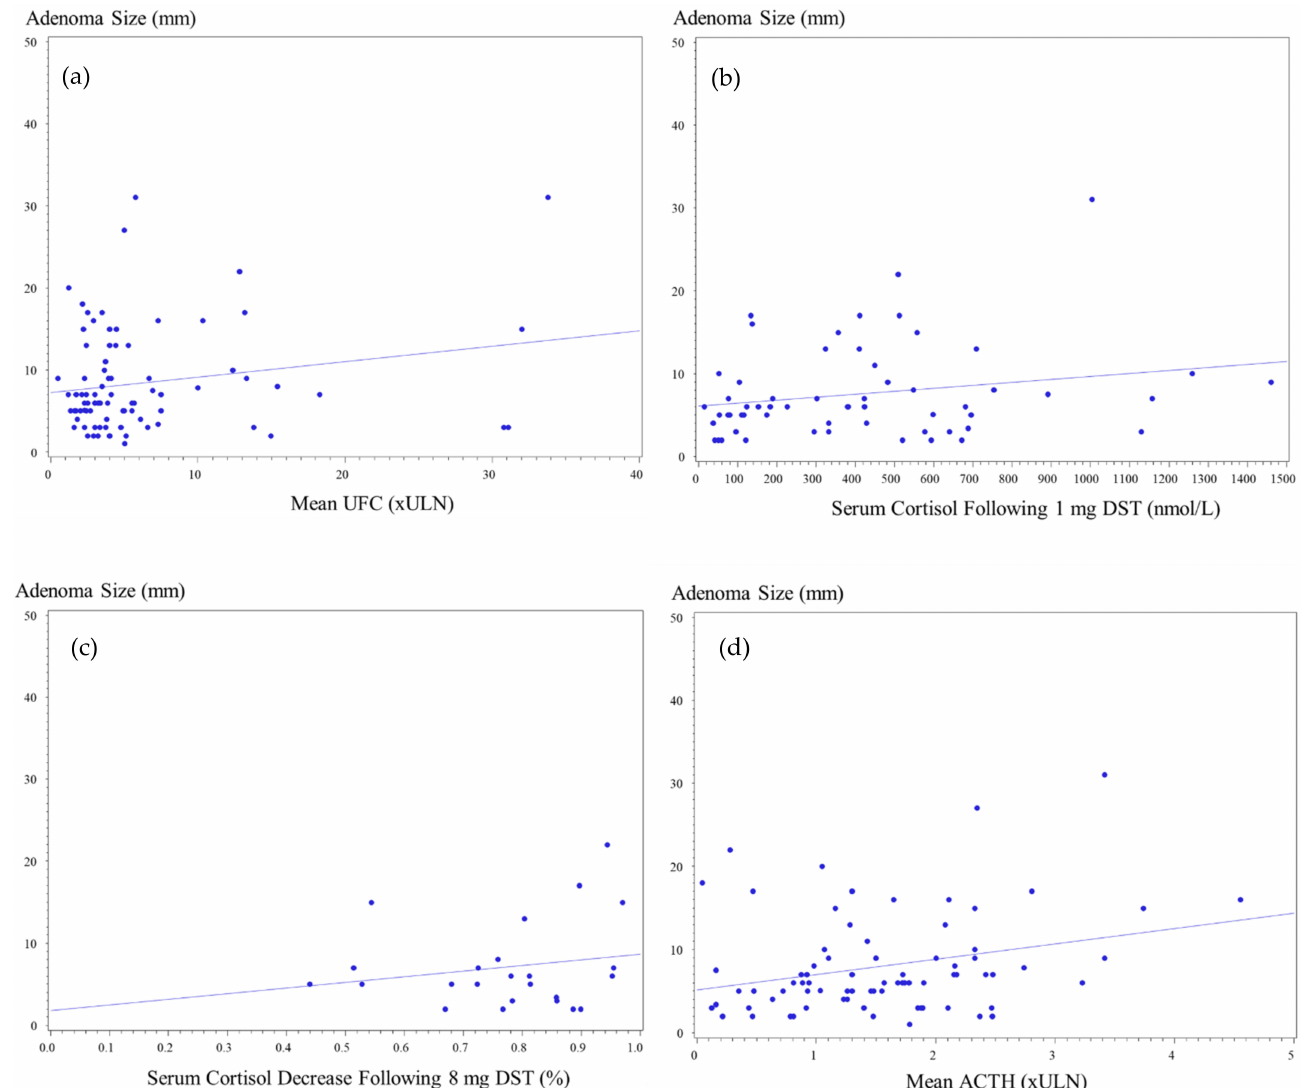
Figure 2. Correlation between adenoma size on MRI and biochemical profile ( a ) mean urinary free cortisol (UFC) ( × ULN), p = 0.41; ( b ) serum cortisol after 1 mg dexamethasone suppression test (DST) (ng/mL), p = 0.09; ( c ) serum cortisol suppression after 8 mg DST (%), p = 0.5; ( d ) adrenocorticotropic hormone ( × ULN), p =